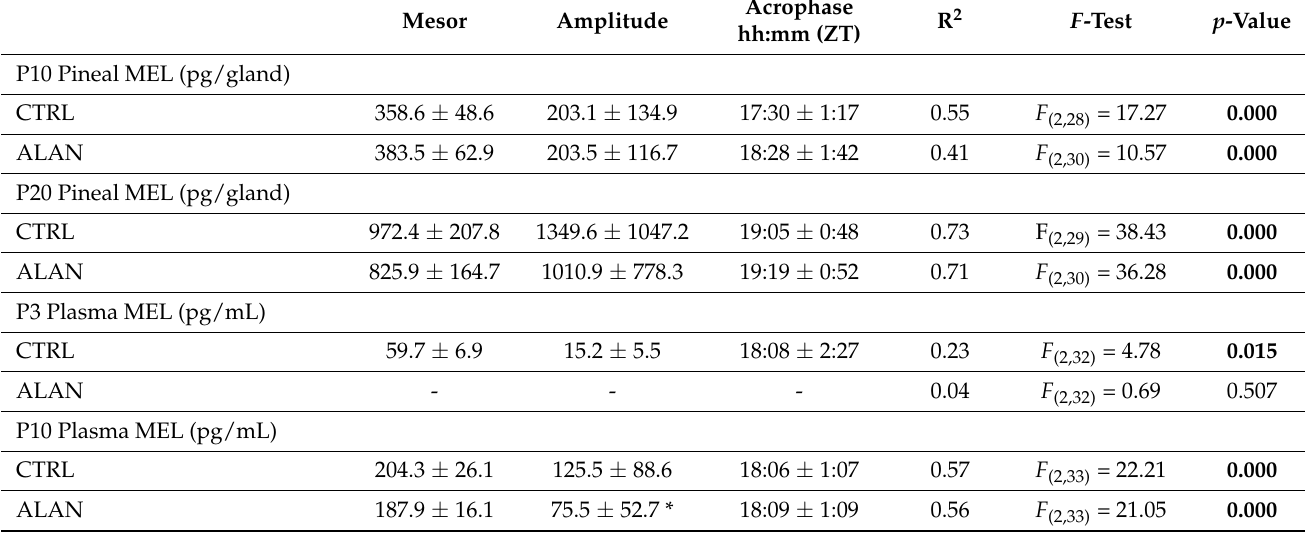
Figure 2. Effects of gestational dim ALAN (~2 lx) on the early development of daily corticosterone rhythms. The daily pattern of plasma corticosterone levels on postnatal day P3 ( A ), P10 ( B ), and P20 ( C ) in rat pups that were delivered by mothers exposed to either the control light–dark cycle (CTRL) or ALAN during pregnancy. Symbols represent the mean ± SEM, n = 5–6 rats per time point and